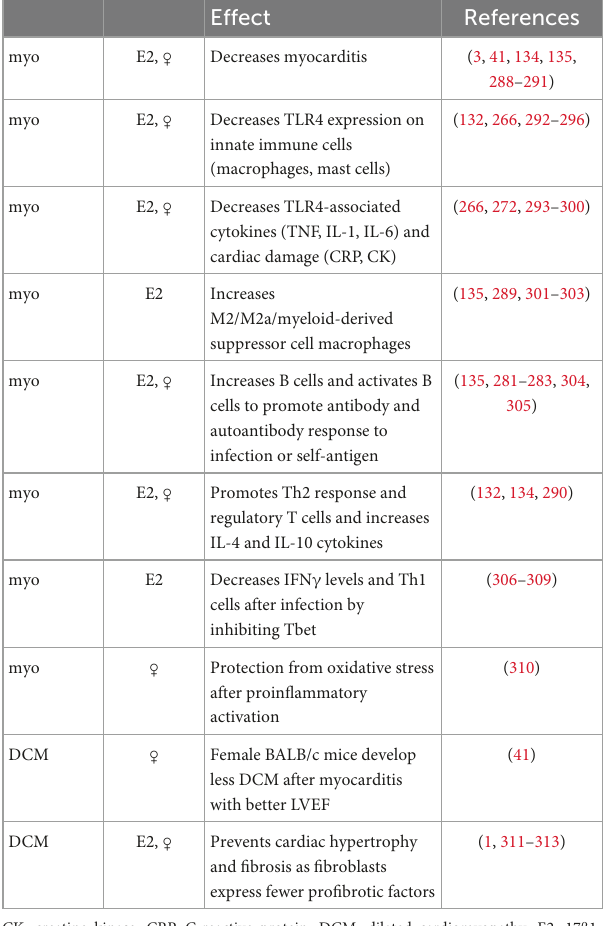
TABLE 5 Effect of estrogen and/or female sex on an inflammatory response or myocarditis from animal models or tissue culture. Effect